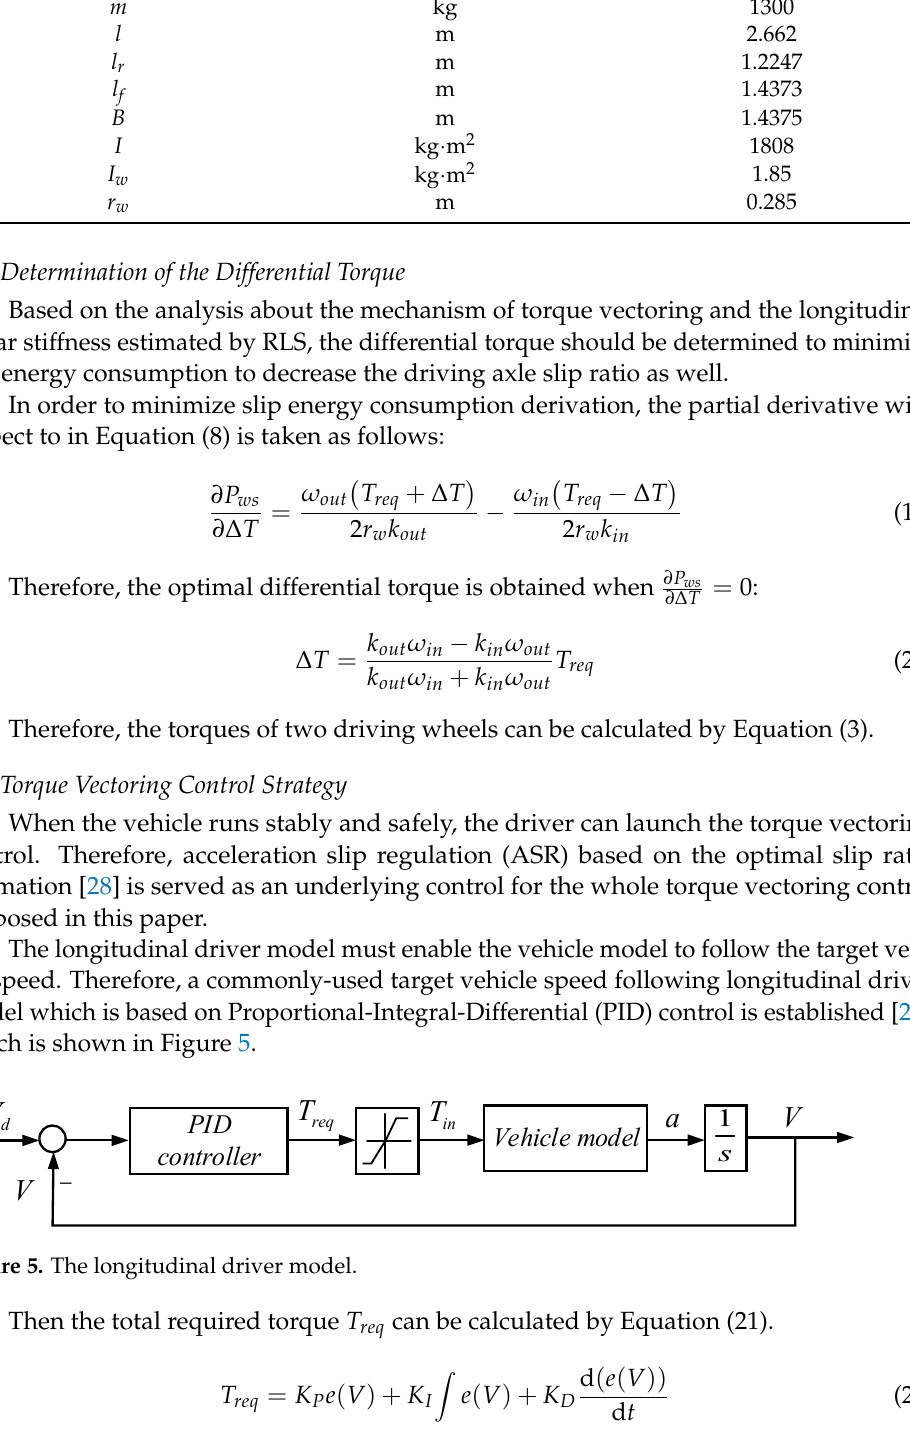
Table 1. Main parameters of the rear-wheel independent-drive (RWID) electric vehicle. Parameter